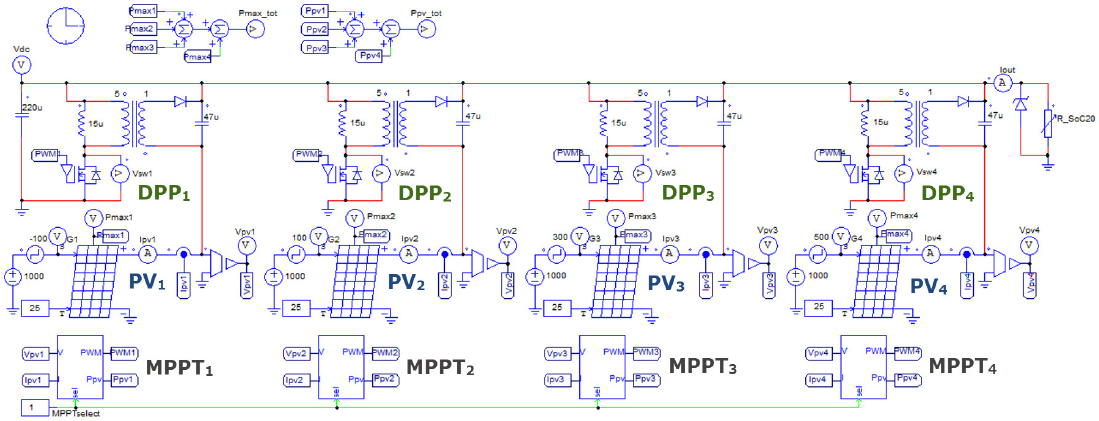
Figure 10. PSIM software circuit diagram of the parallel DPP converter system for four PV modules.